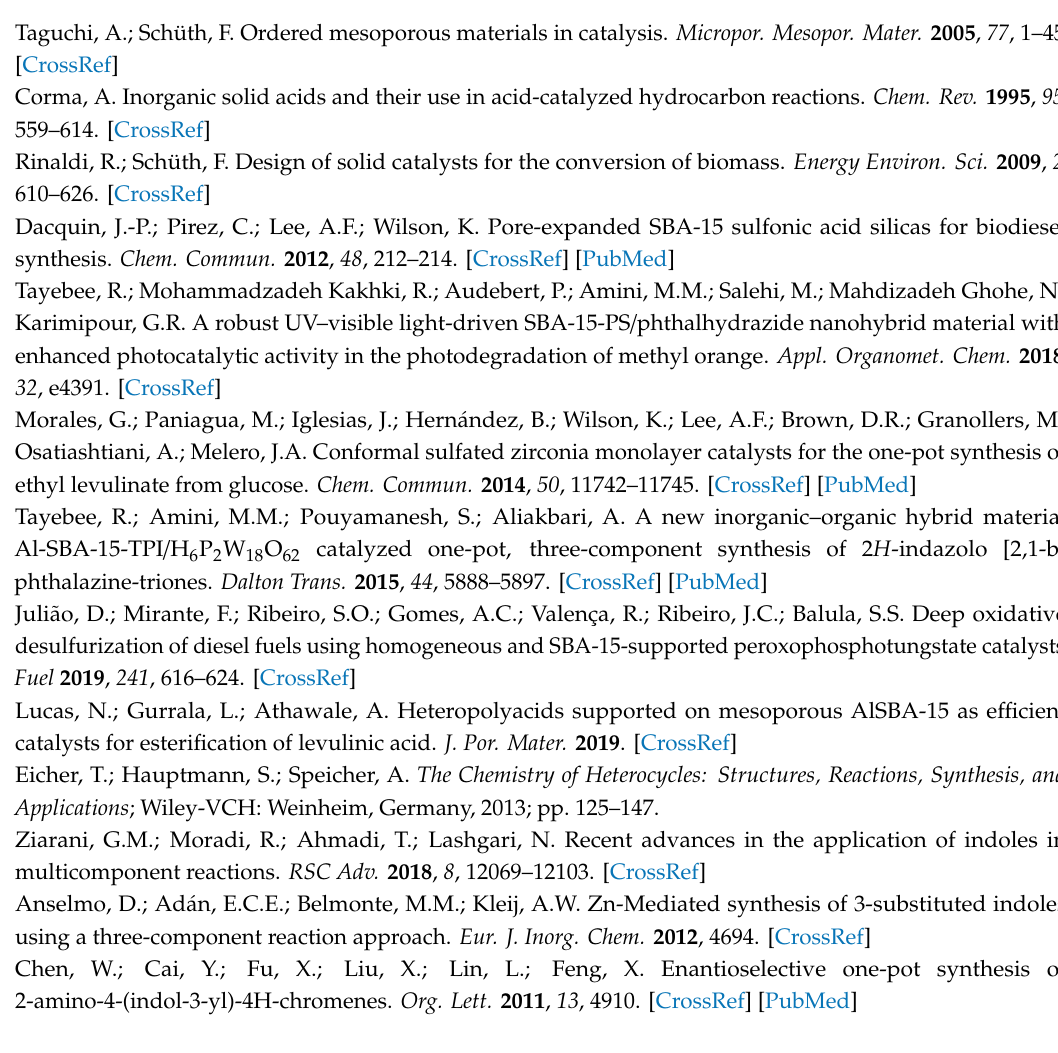
Figure S1: Powder XRD patterns for HPW / SBA-15 as a function of W loading, together with a pure HPW reference; Figure S2: Variation of (a) surface areas of HPW / SBA-15 and (b) mesopore diameter and mesopore volume of HPW / SBA-15 as a function of bulk W loading; Figure S3: HRTEM dark-field images of 3.2 wt % HPW / SBA-15 (a) and 51.6 wt % HPW / SBA-15 (b); Figure S4: NH 3 TPD spectra for HPW / SBA-15 as a function of W loading. Figure S5: Yield as a function of reusability for 51.6 wt % HPW / SBA-15; Figure S6: FT-IR spectra of 51.6 wt % HPW /